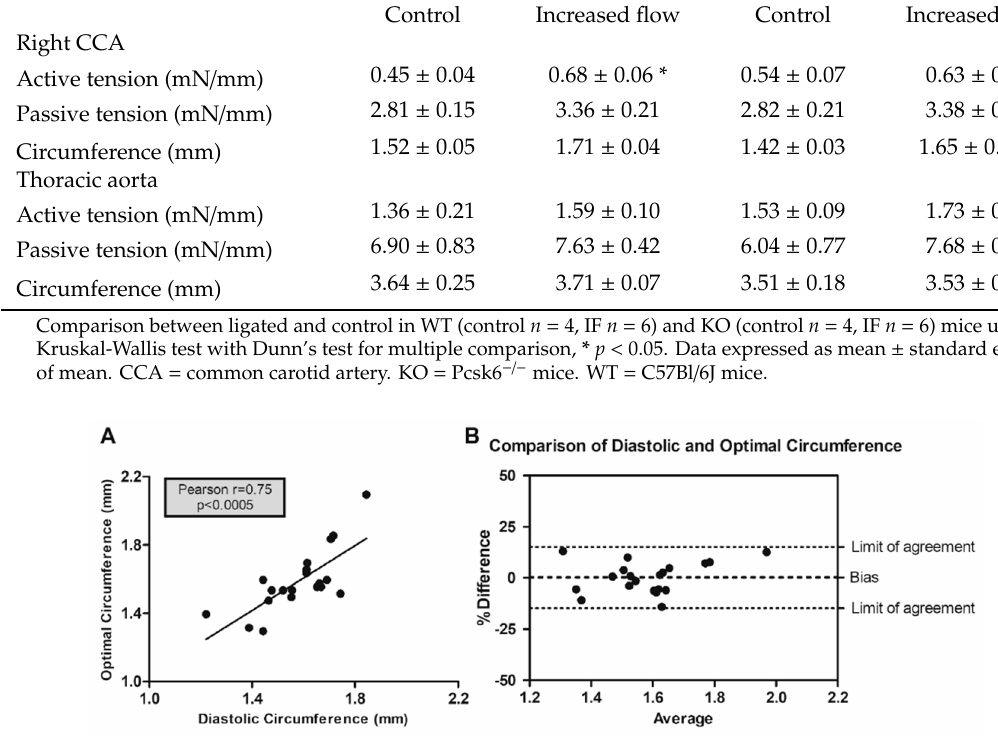
Figure 3. Comparison of the right common carotid artery circumference measured by wire myography and ultrasound biomicroscopy. A significant correlation was detected when comparing circumferences ( A ), measured in diastolic phase by ultrasound biomicroscopy and at optimal stretch in wire myography. ( B ) Bland-Altman method of comparison, visualized as percent difference, revealed an agreement between the methods (bias = 0.27%, standard deviation = 7.63%). The analysis includes data from Pcsk6 KO and WT mice under normal (WT n = 4, KO n = 4) and increased flow (WT n = 6, KO n = 6) conditions. KO = Pcsk6 − / − mice. WT = C57Bl/6J mice.